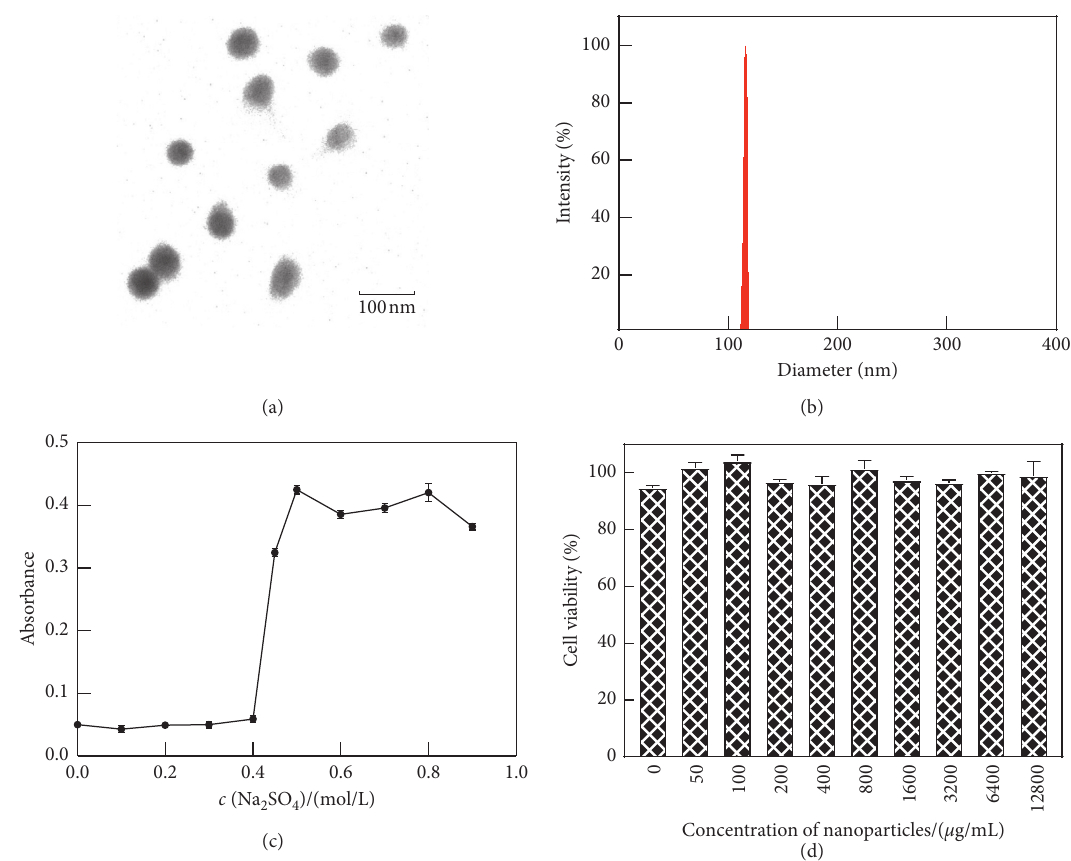
Figure 1: Characterization of PEG-PLGA/PUE nanoparticles. (a, b) Size distribution and TEM image of PEG-PLGA/PUE nanoparticles. (c) Absorbance of nanoparticles. (d) Cell viability (data are shown by mean ± SD, N �